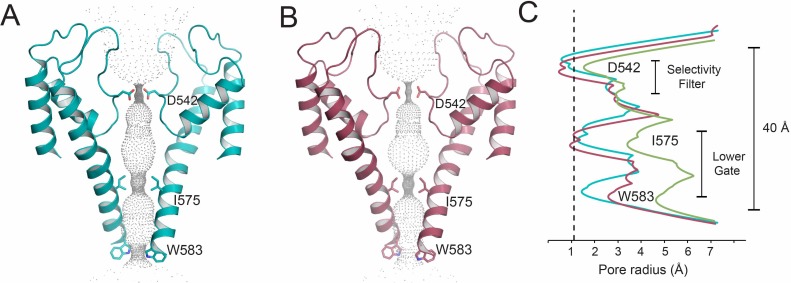
Inhibition of TRPV5 by novel compounds.(A) Cartoon dimer pore of ZINC9155420-bound TRPV5 with constriction residues labeled and shown as sticks. (B) Cartoon dimer pore of ZINC17988990-bound TRPV5 with constriction residues labeled and shown as sticks. Gray dots indicate the diameter of the pore. (B) Graphical representation of the pore radii of ZINC9155420-bound (teal), ZINC17988990-bound (red) and PI(4,5)P2-bound (green) TRPV5. The dotted line indicates the radius of a dehydrated calcium ion. Constriction residues are labeled.